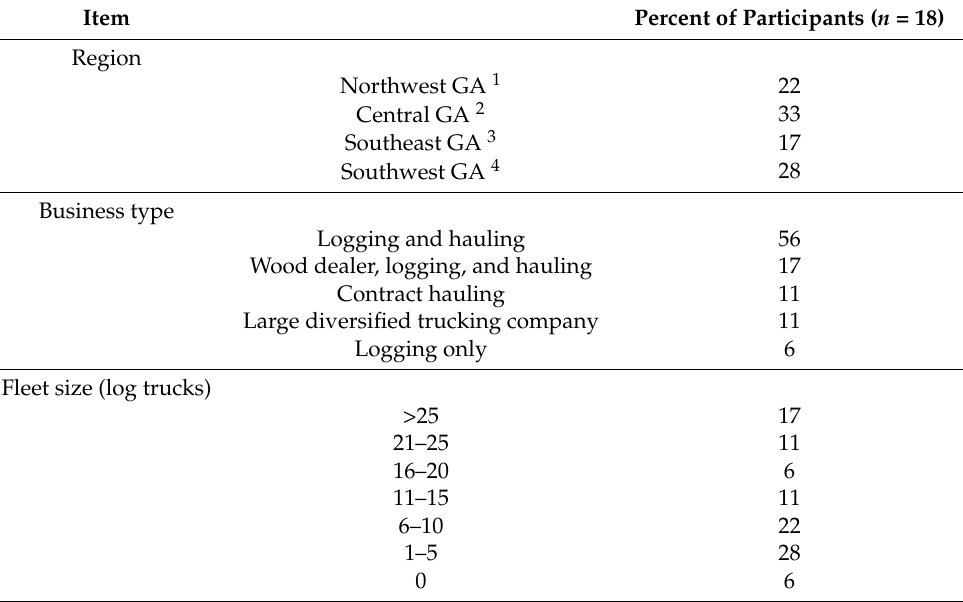
Table 1. Profile of 18 log truck owners in Georgia (GA), U.S. that were interviewed during July and August 2017. Values in columns may not sum to 100 due to rounding